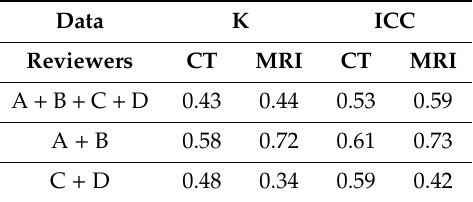
Table 4. Inter-observer agreement regarding liver segments that were a ff ected by the liver metastases of pancreatic ductal adenocarcinoma (LM of PDAC) ( κ ) and the number of lesions reported per patient (ICC) for CT and MRI analyses. The experienced reviewers showed a significantly higher agreement for MRI than for CT